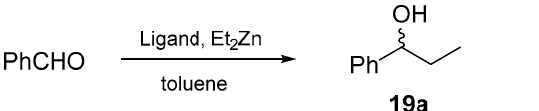
Table 3. Asymmetric addition of Et 2 Zn to benzaldehyde in the presence of 1 – 12